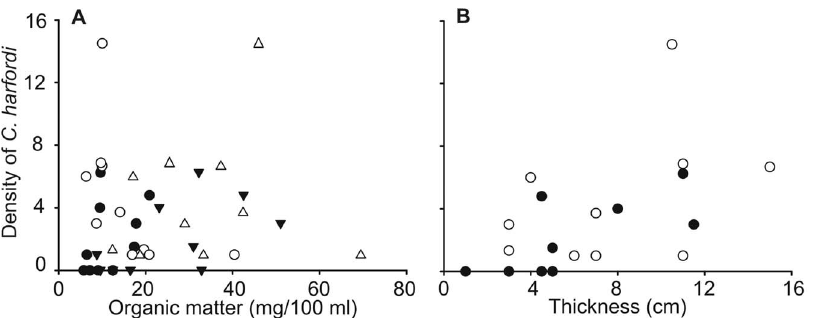
Figure 4. Relationships between C.harfordi and organic matter and thickness of the habitat. Densities of Cirolana harfordi and (A) concentration of organic matter smaller than 64 m m (triangles) and 64–500 m m (circles) and (B) thickness of the oyster-bed at Greenwich (white) and Berrys Bay (black)